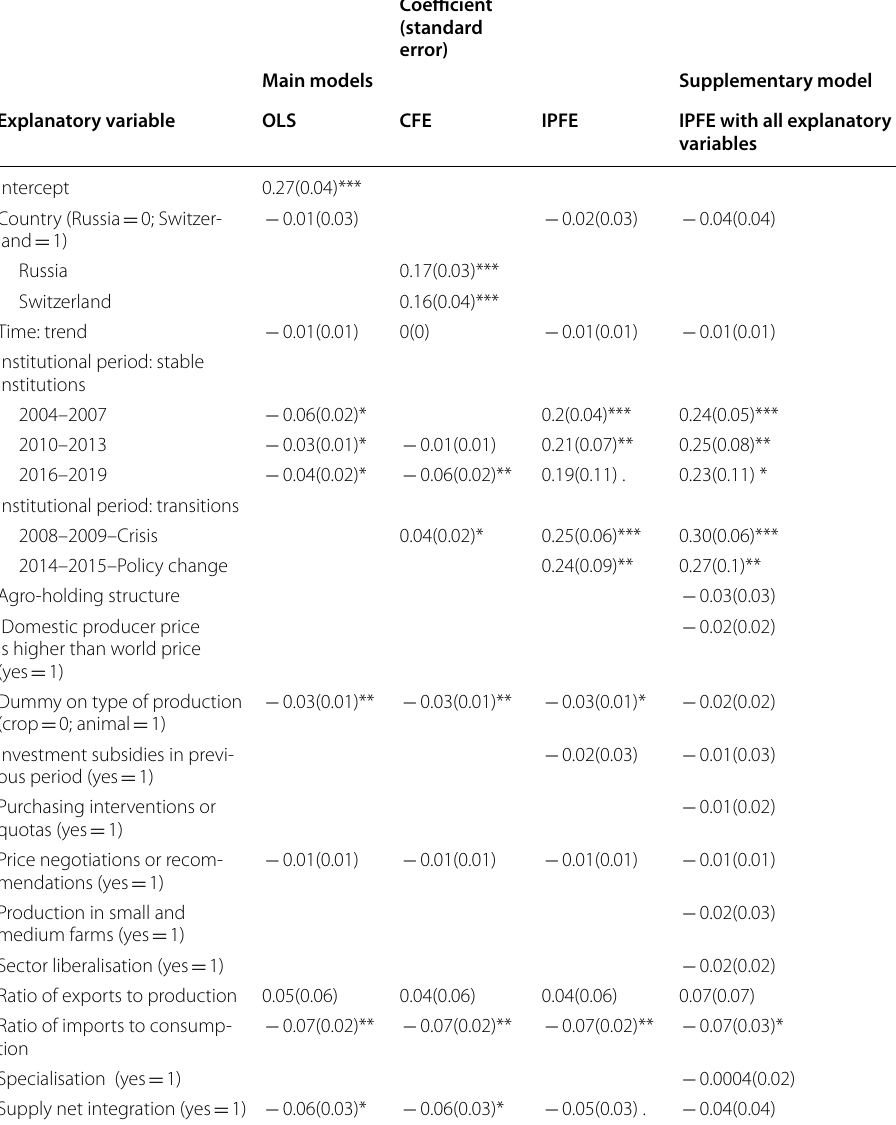
Table 2 Results of models explaining the coefficients of producer price